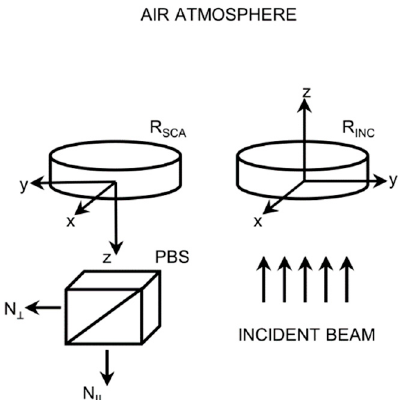
Figure 1. Optical scheme of the matrix polarization lidar. Here, ‘incident beam’ denotes the laser radiation, R INC is the transmitter wave plate, R SCA is the receiver wave plate, PBS is the polarization beam splitter, and N II and N ⊥ are the orthogonal recorded signals. The receiving collimator and the recording system are not shown here.